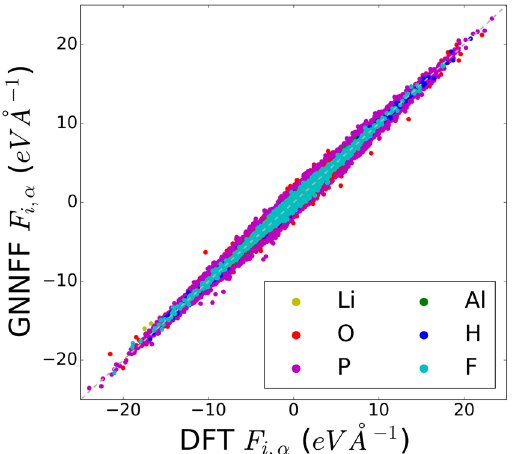
Fig. 2 Performance of GNNFF in predicting forces of solid-state systems. GNNFF-predicted vs DFT-calculated force correlation plots of elements from the Li 4 P 2 O 7 and Al 2 O 3 -HF MD systems. F i , α ( α ∈ { x , y , z }) represents the Cartesian force component of atom i